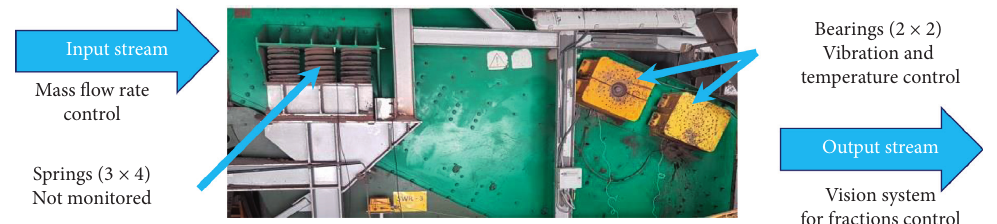
Figure 3: Components of the monitoring system on the vibrating screen (nondriven side) with two exciters.